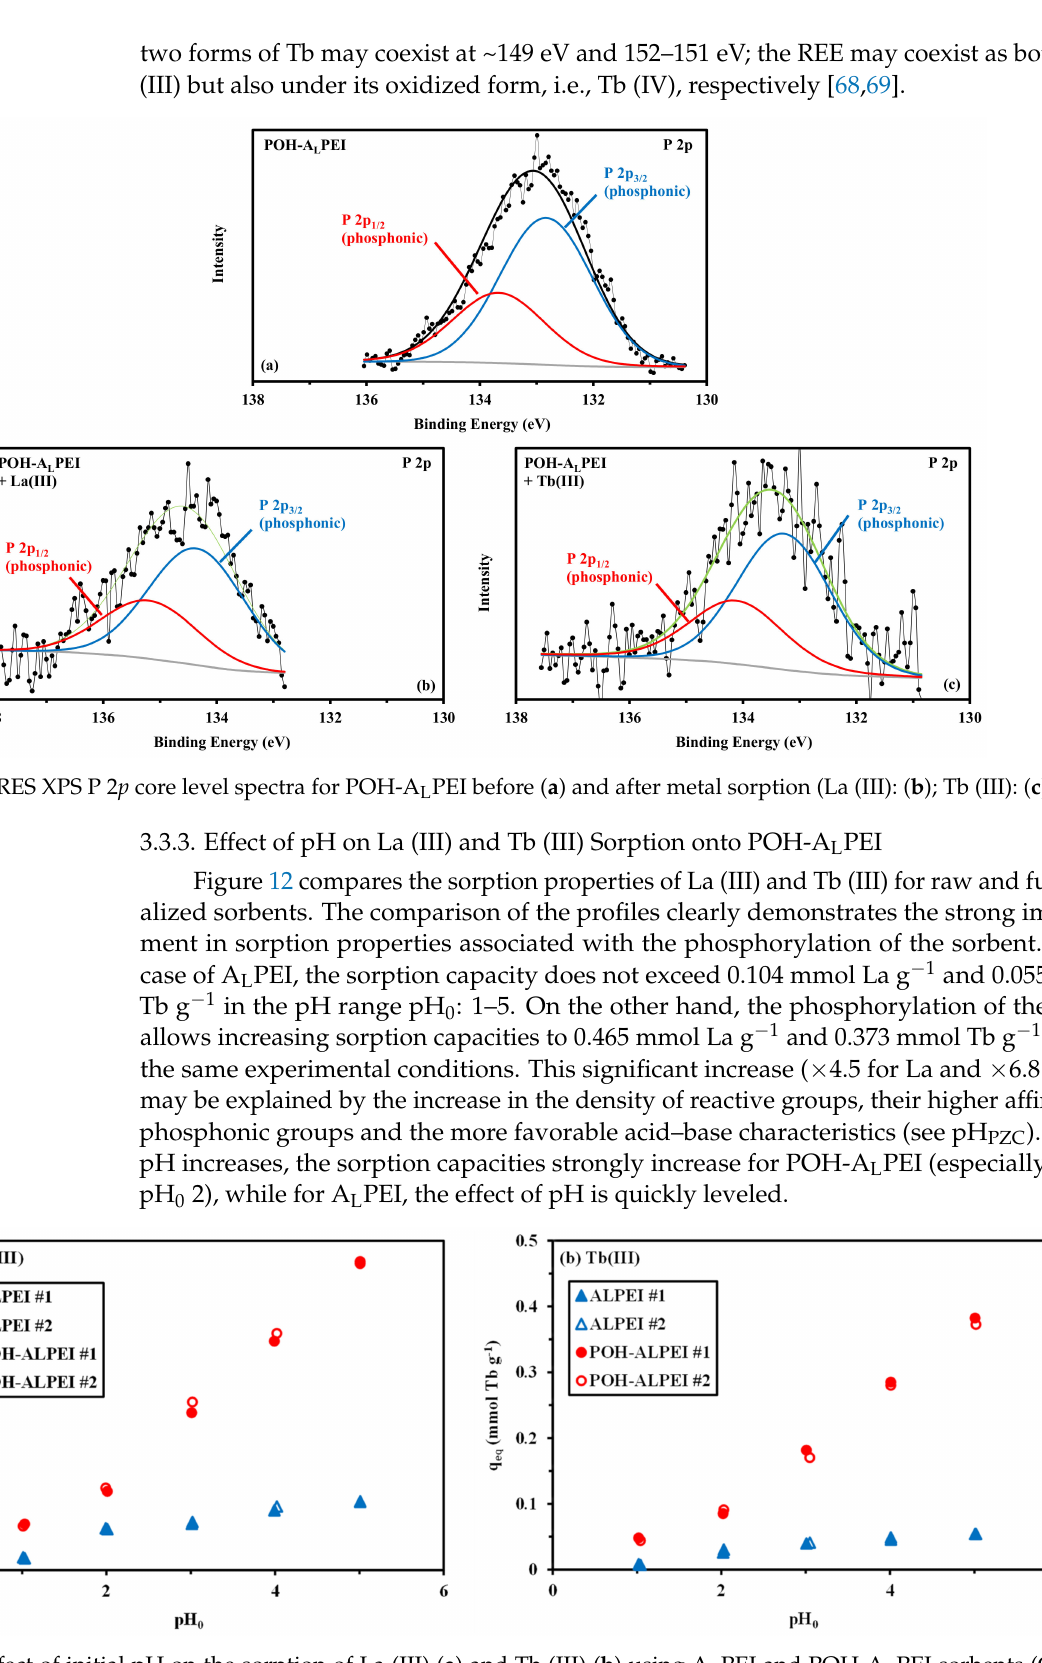
Figure 12. Effect of initial pH on the sorption of La (III) ( a ) and Tb (III) ( b ) using A L PEI and POH-A L PEI sorbents (C 0 : 50 mg L − 1 = 0.374 mmol La L − 1 or 0.332 mmol Tb L − 1 ; Sorbent dose, SD: 0.66 g L − 1 ; time: 48 h; T: 21 ± 1 ◦